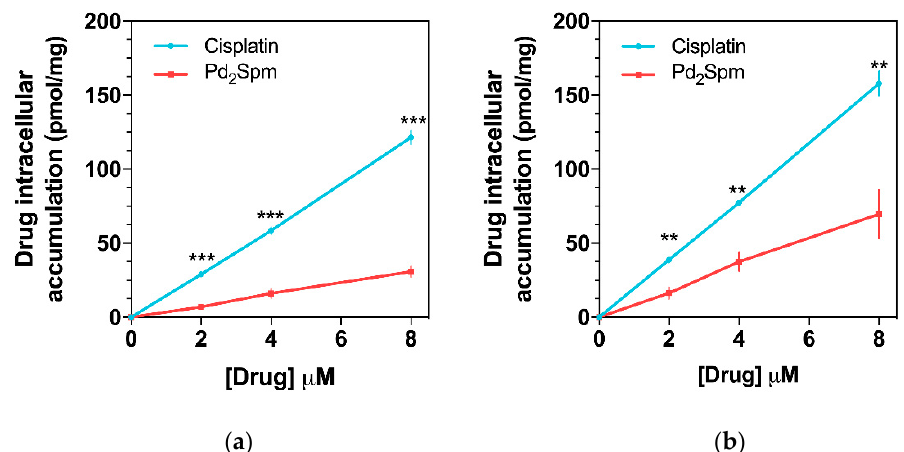
Figure 5. Cellular accumulation of Pd 2 Spm and cisplatin in ( a ) MDA-MB-231 and ( b ) HCC-1143 triple-negative breast cancer cells. Data are expressed as mean ± SEM ( n = 4 independent experiments) and were compared with Student’s t -test. ** p < 0.01, *** p < 0.001.